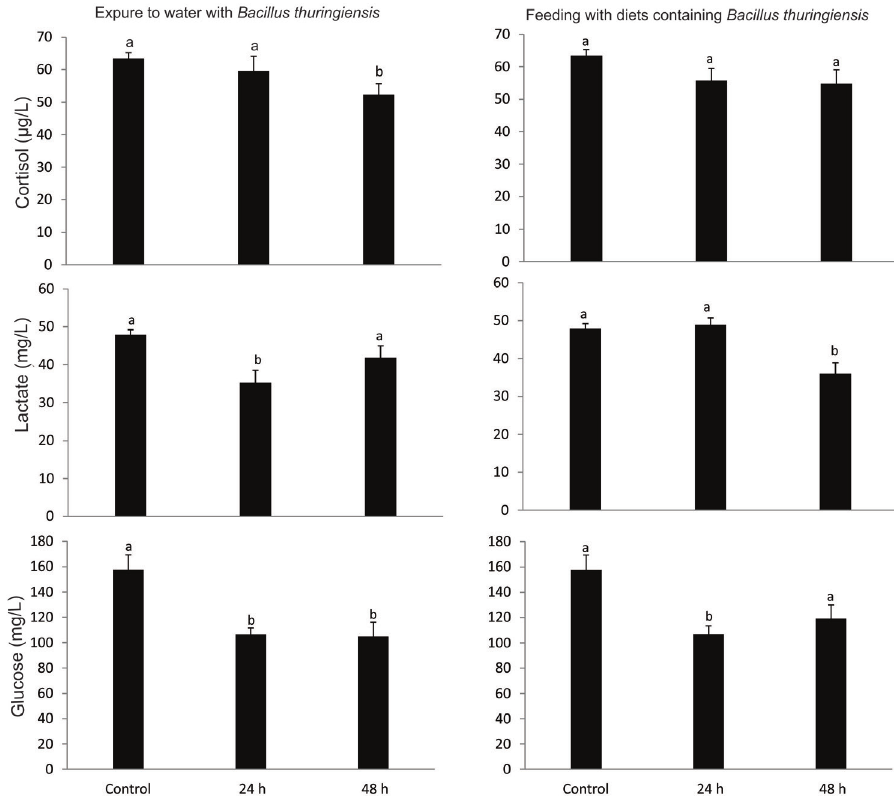
Figure 1 - Plasma levels of cortisol, lactate and glucose of Piaractus mesopotamicus exposed to water or diets containing biopesticide based on Bacillus thuringiensis . Values express mean and standard deviation. Different letters indicate differences by the Tukey test